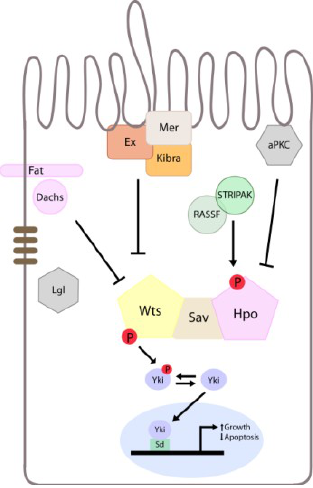
Figure 5. Schematic model of Lgl/aPKC function in Hippo signalling. For simplicity,